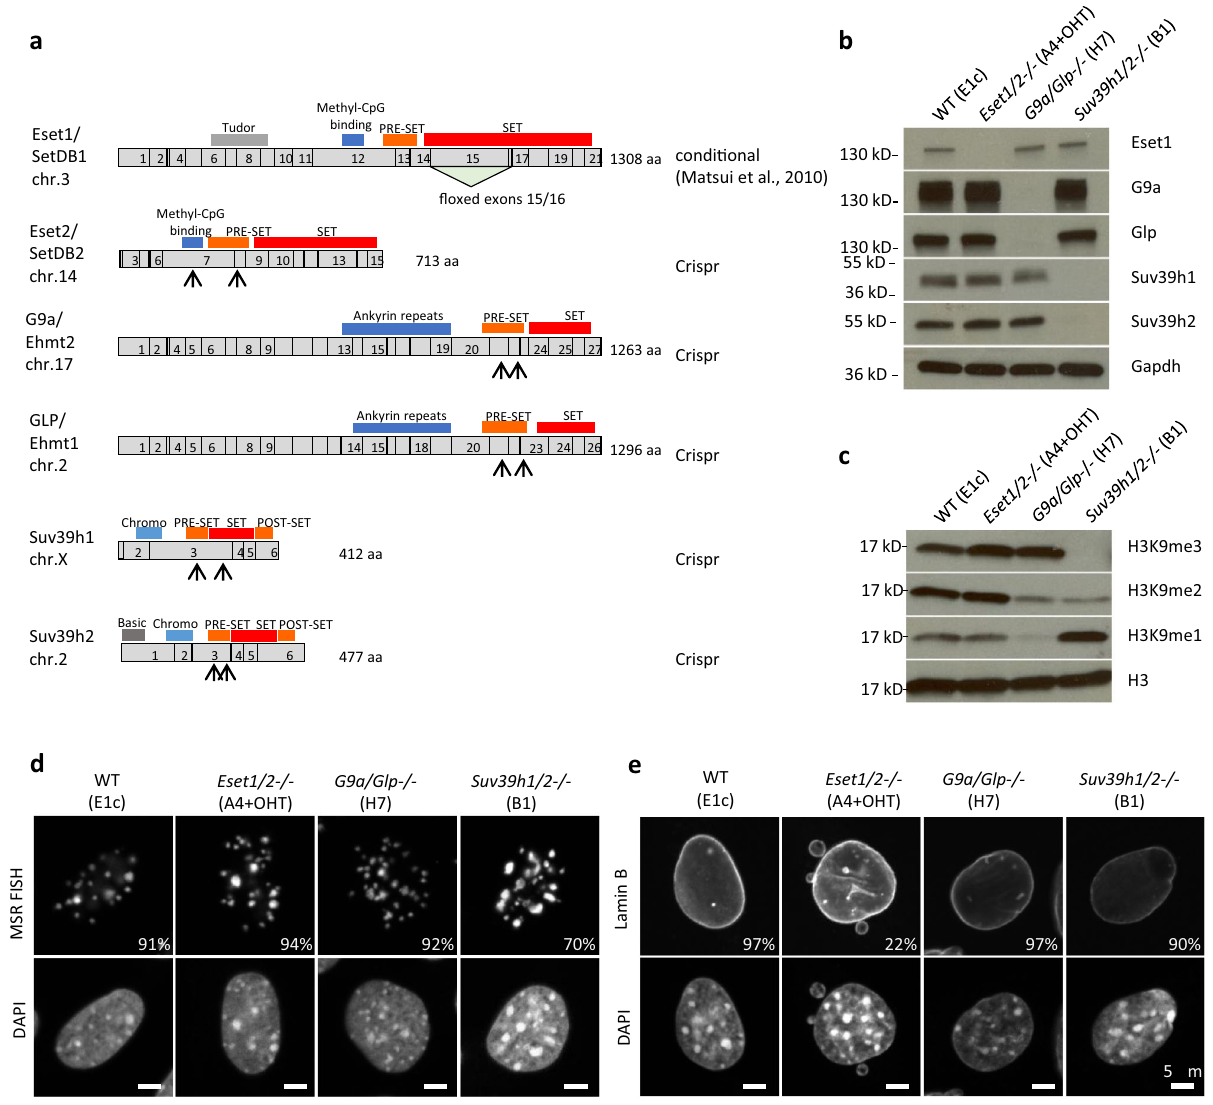
Fig. 1 Three distinct gene pairs encode H3K9 KMT enzymes in the mouse genome. a Domain structure of the six SET-domain H3K9 KMT. For each gene, numbered boxes indicate exons, and conserved protein domains are indicated above the gene structure. The triangle below Eset1 illustrates the fl oxed exons deleted upon tamoxifen treatment. For the other SET-domain H3K9 KMT genes, disruptions were generated by CRISPR/Cas9 technology, with the location of the gRNAs indicated by arrows below the gene structure. b Gene pair mutants lacking either Eset1/Eset2 , G9a/Glp , or Suv39h1/Suv39h2 . Western blots were performed on whole-cell extracts of the mutant clones (top) using speci fi c antibodies indicated on the right. Gapdh was used as a loading control. Eset1 deletion was probed with extracts after 2 days of induction in culture with 4-hyroxytamoxifen (4-OHT, 1 μ M) followed by 2 days in a normal medium. Representative results of two independent experiments. c Western blot analysis of H3K9 methylation states in H3K9 KMT gene pair